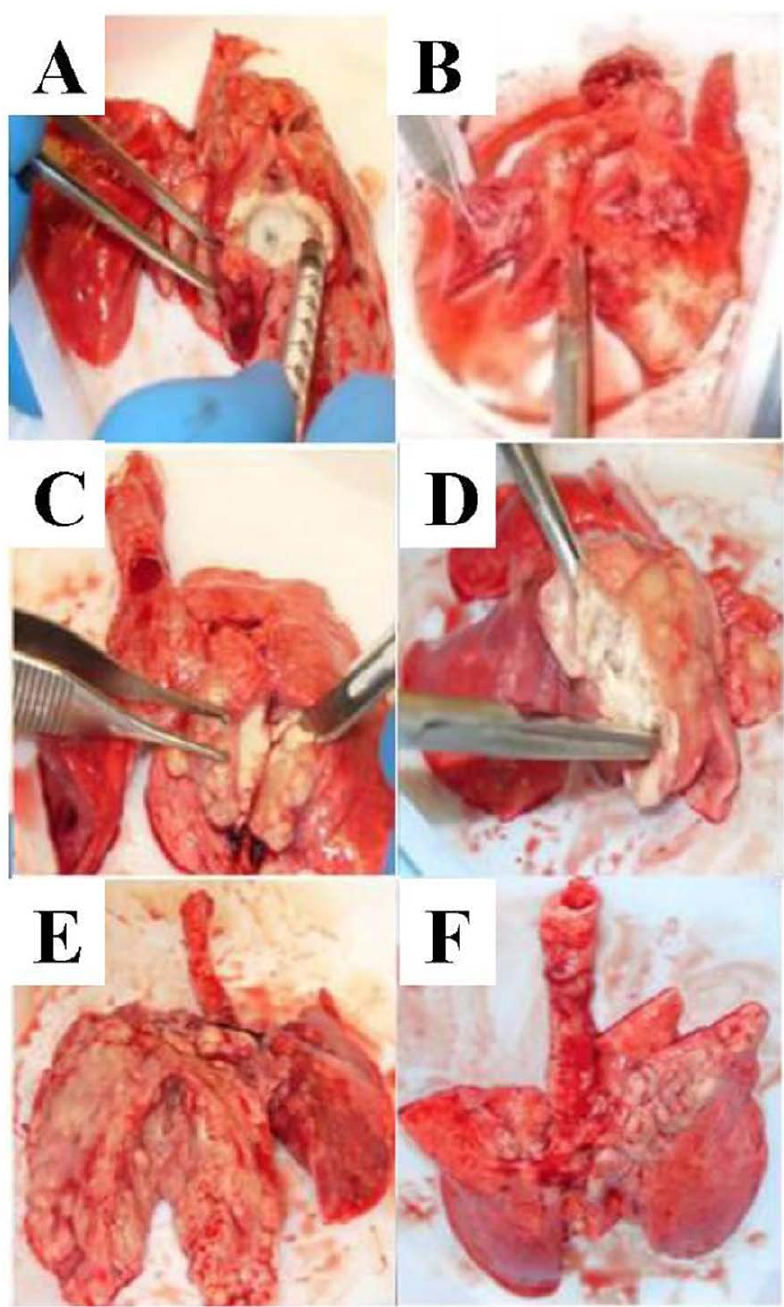
Figure 2. Gross pathology of selected lung specimens at necropsy. (A) M. tuberculosis H37Rv T1. (B) M. tuberculosis H37Rv T2. (C) M. bovis B1. (D) M. bovis B2. (E) M. bovis B3. (F) M. bovis B4.